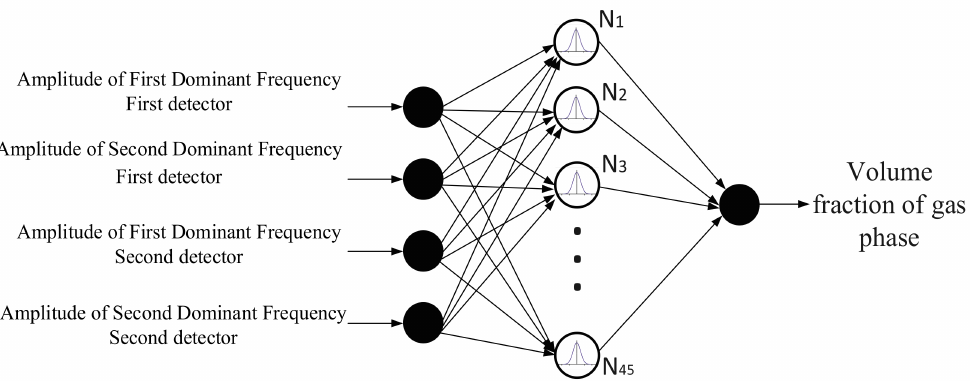
Figure 6. The structure of the gas phase volume fraction predictor RBF neural